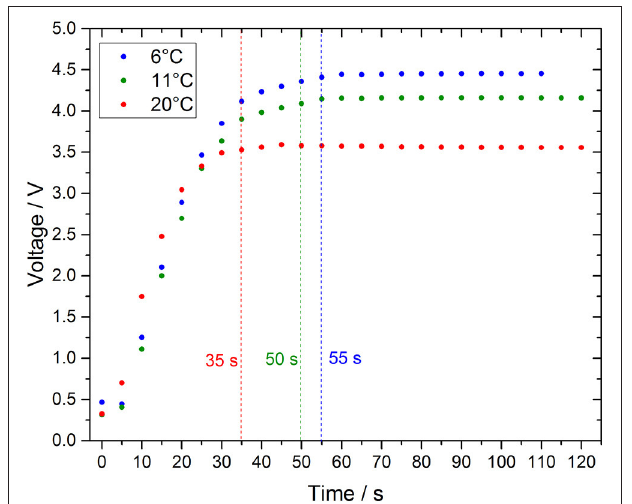
FIGURE 4 | Required time to allow complete mixing and stable color development of a 40nM Fe(II) standard with 10mM FZ in a de-ionized water matrix using the long measurement cell. The raw voltage signal of the photodiode of the long cell is shown here (inversely proportional to absorbance). Response times are given as τ 99 , when the detector output corresponds to 99% of the maximum signal. Differences in the final recorded voltage for the three applied temperatures after stable signals are obtained due to the temperature dependent signal output of the photodiodes.